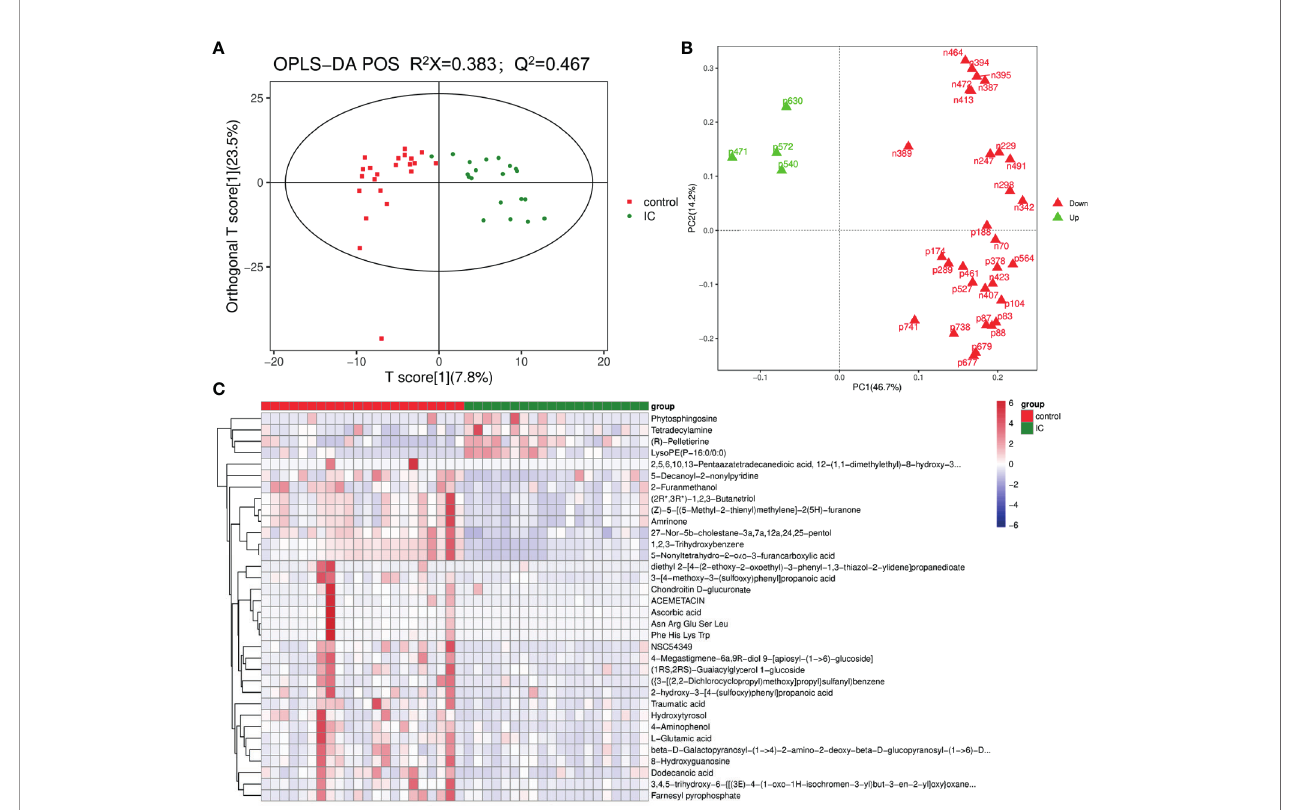
FIGURE 3 | OPLS-DA score plot of IC patients and controls based on the urinary metabolic pro fi les (A) . The red box and green triangle represent controls and IC samples, respectively. OPLS-DA loading plot (B) . The green font denotes the metabolites with VIP > 1.5, and the red font denotes the metabolites with VIP < 1.5. Heatmap (C) . The red box and green triangle represent controls and IC samples,